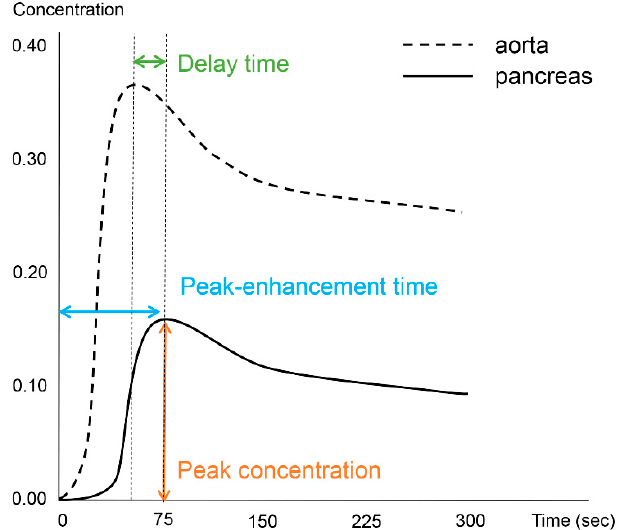
Figure 1. Schematic diagram illustrative of the investigated perfusion parameters.